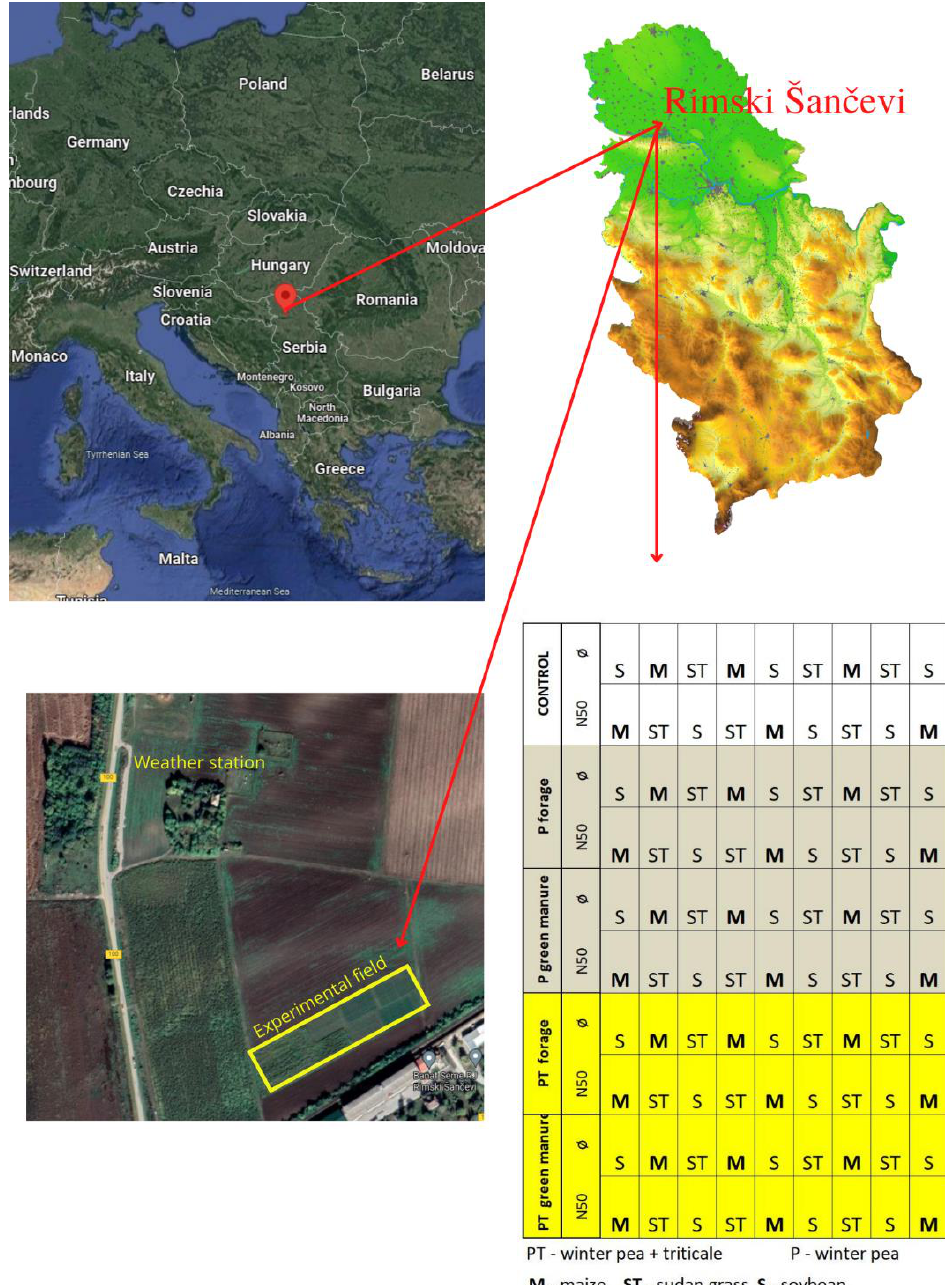
Figure 1. Location of the trail and experimental design showing the main analyzed factors: cover crops (CC) type and way of using CC (PT: winter pea + triticale, for green manure and for forage; P: winter pea as a sole crop, for green manure, and for forage; Ø: control treatment-without CC), and N fertilization treatments (N50: with N fertilizer of 50 kg ha − 1 , NØ: without N fertilizer application).